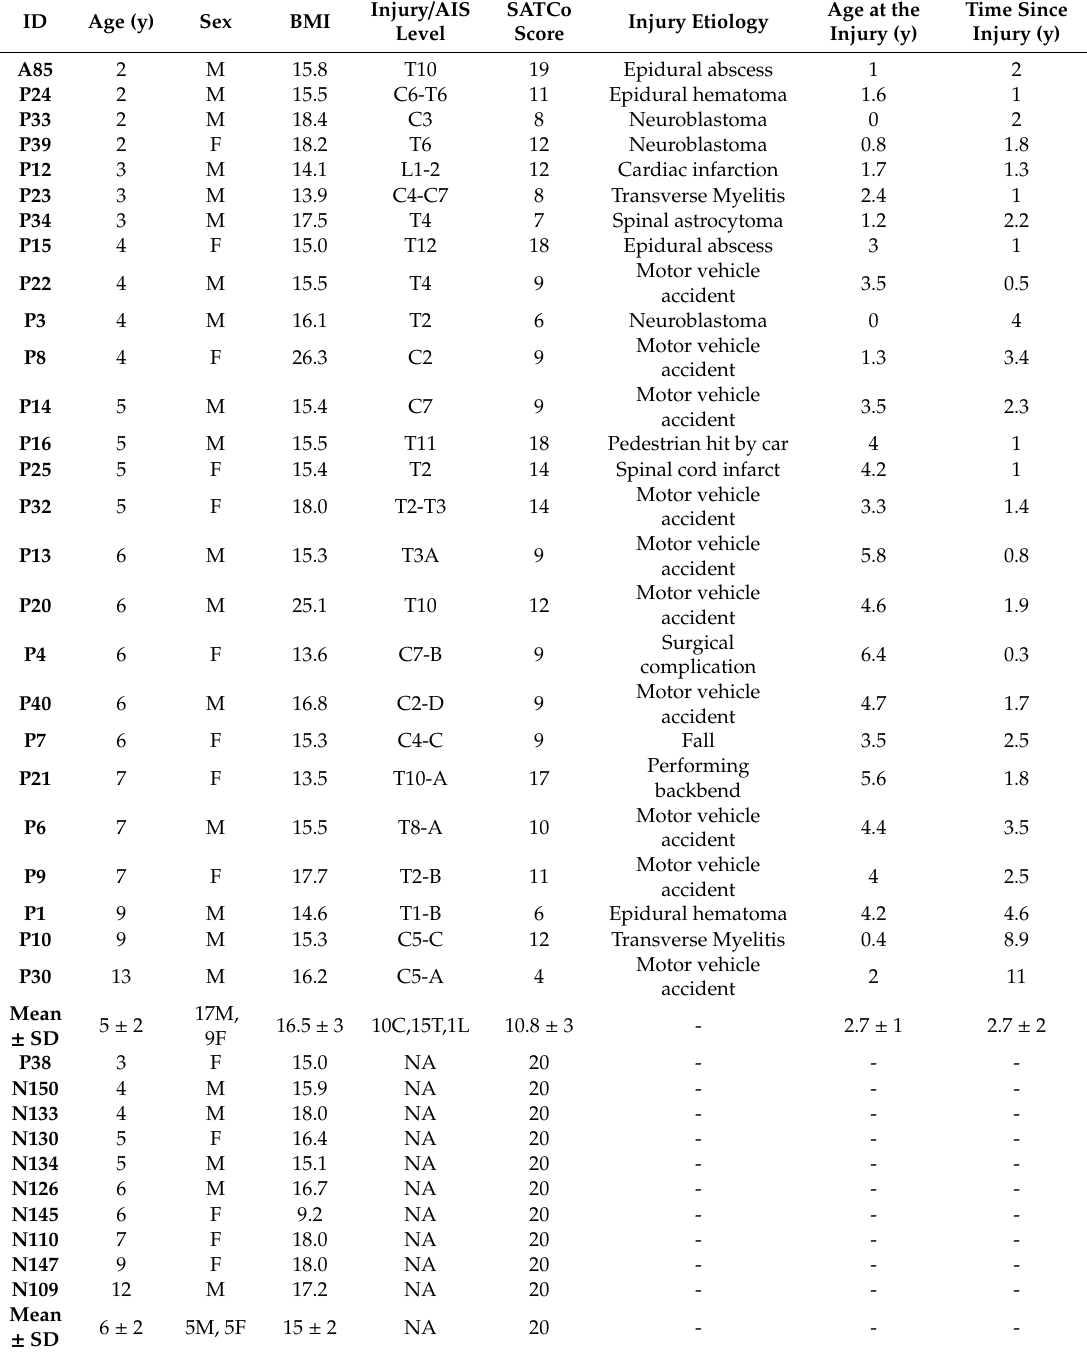
Table 1. Demographic characteristic of children with spinal cord injury and typically developing